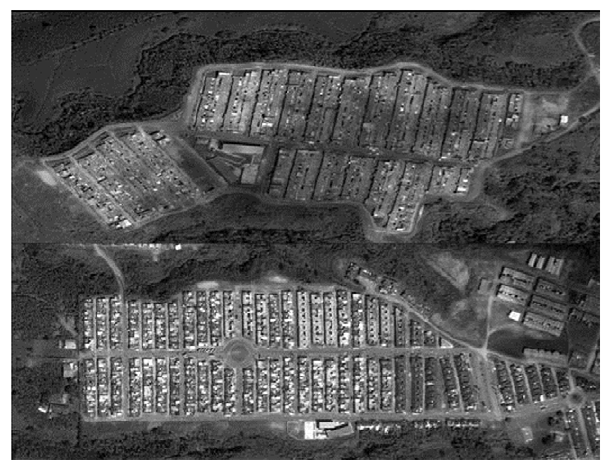
Figure 1. Neighborhoods of study in the city of Armenia,